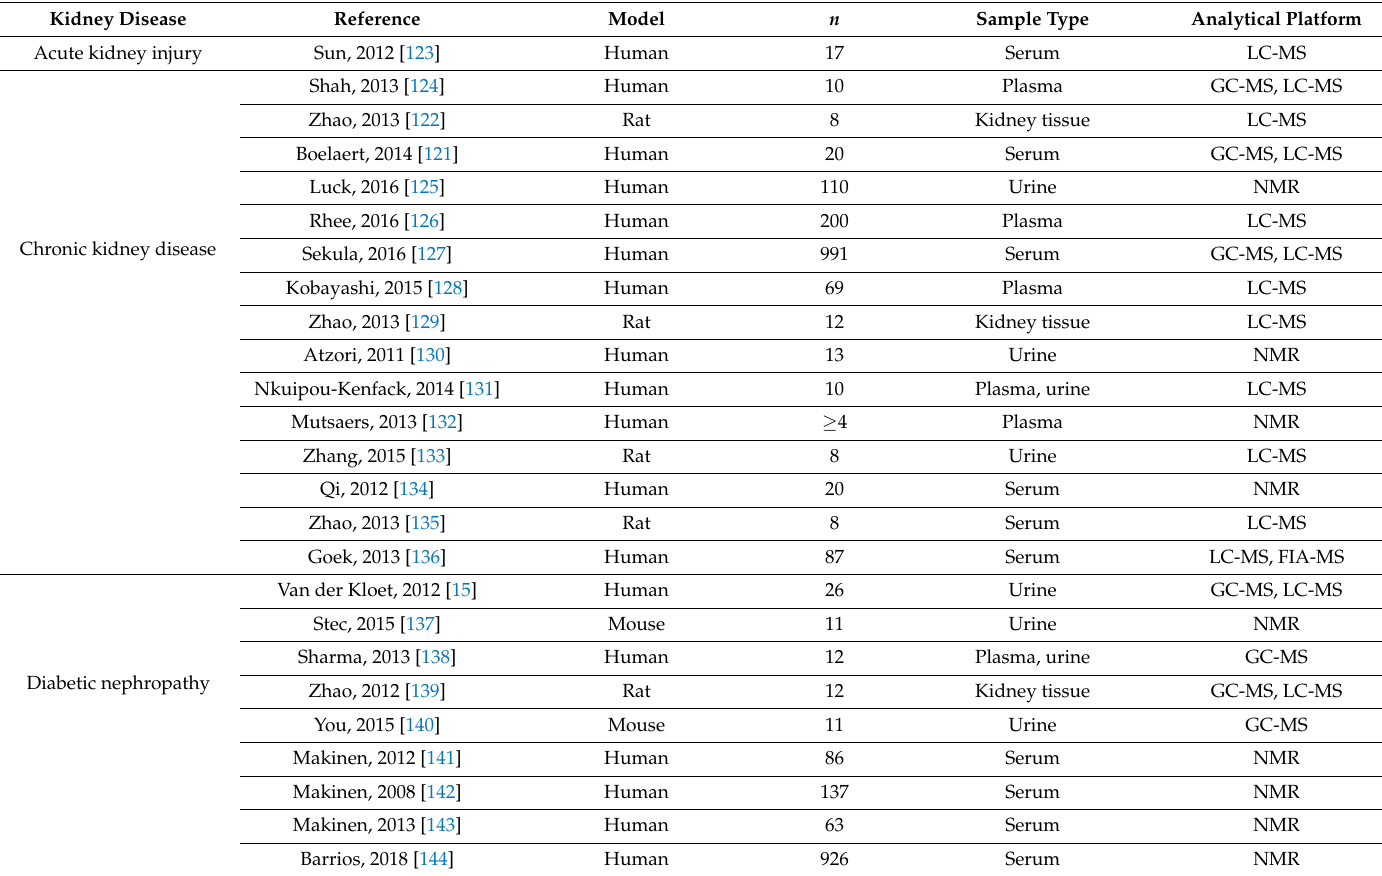
Table 2. Selection of metabolomic studies of kidney disease. n = minimum number of samples in a study group reported for any sample